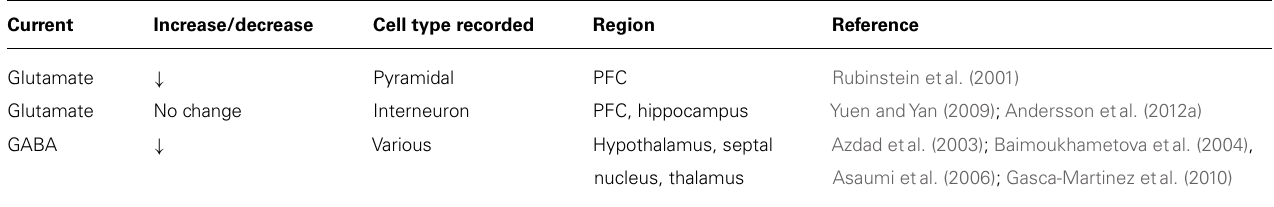
Table 2 | Presynaptic effects of D4R activation